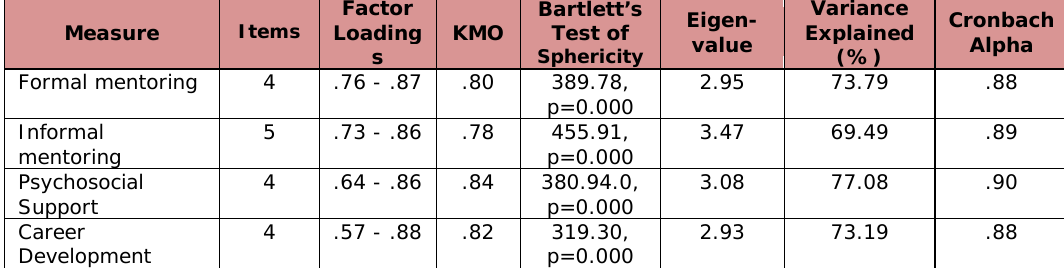
Table 3. “The validity and reliability analyses for measurement scales”. Source: authors